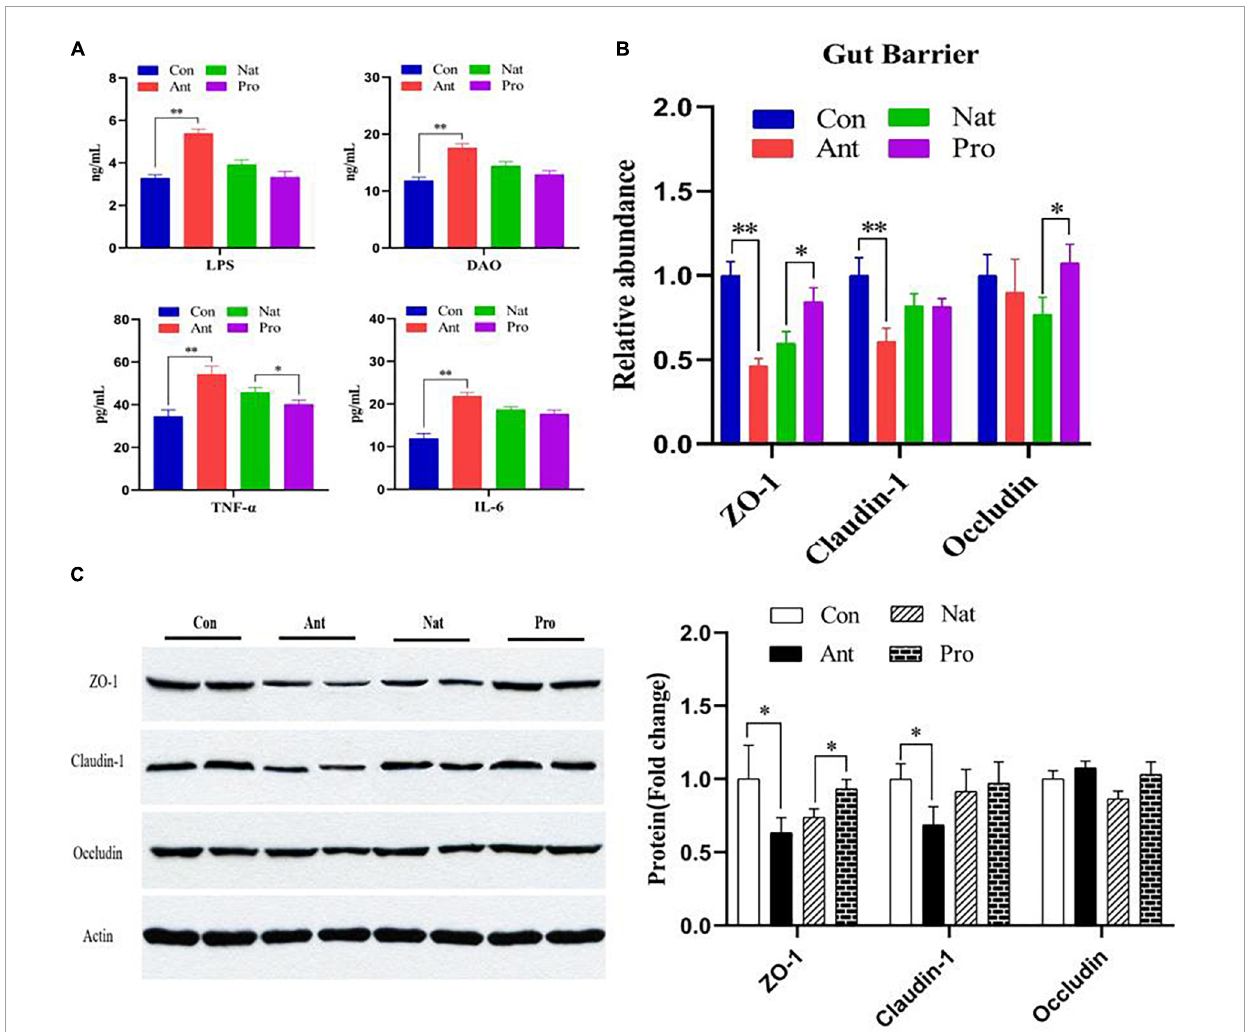
FIGURE4 Effects of dietary probiotic supplementation on the ileum barrier integrity and inflammation response in antibiotic-treated hens. (A) Graphs showing the concentrations of LPS, DAO, TNF- α , and IL-6 in the serum of laying hens following different treatments. (B) Graph showing the relative mRNA expression of ZO-1, claudin-1, and occludin in the ileum of laying hen ( n = 7). The β -actin was used as an internal control. (C) Representative Western blot (left) and quantified protein expression data (right) of ZO-1, claudin-1, and occludin ileum the ileum of laying hen ( n = 4). Quantification data were normalized to β -actin. Data presented as mean ± SD with significance defined as *P < 0.05, **P <